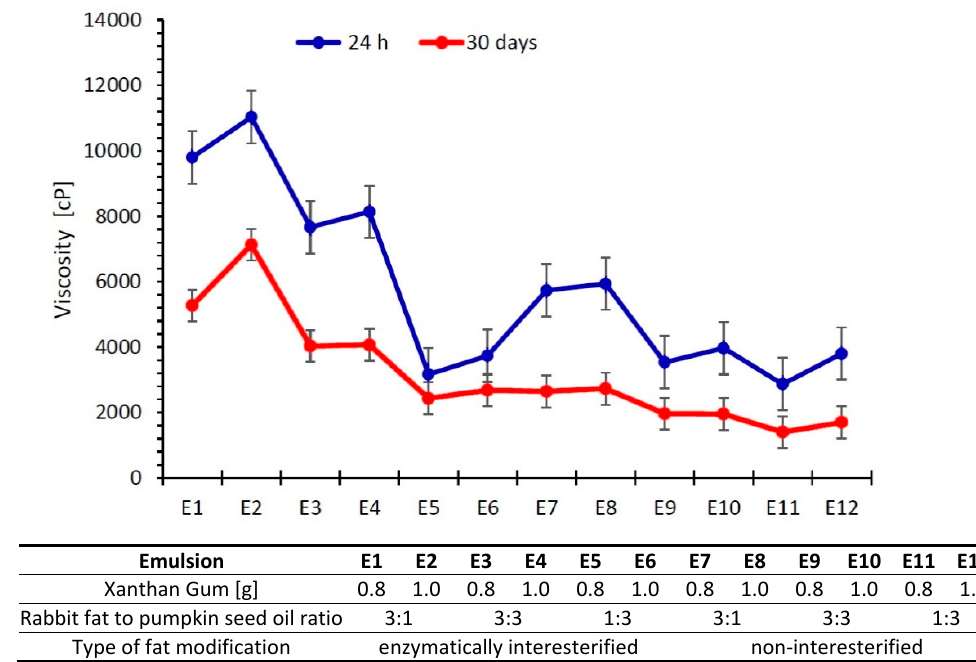
Figure 2. Viscosity of emulsions after 24 h and 30 days from their preparation (as a mean value of three determinations ± SD).